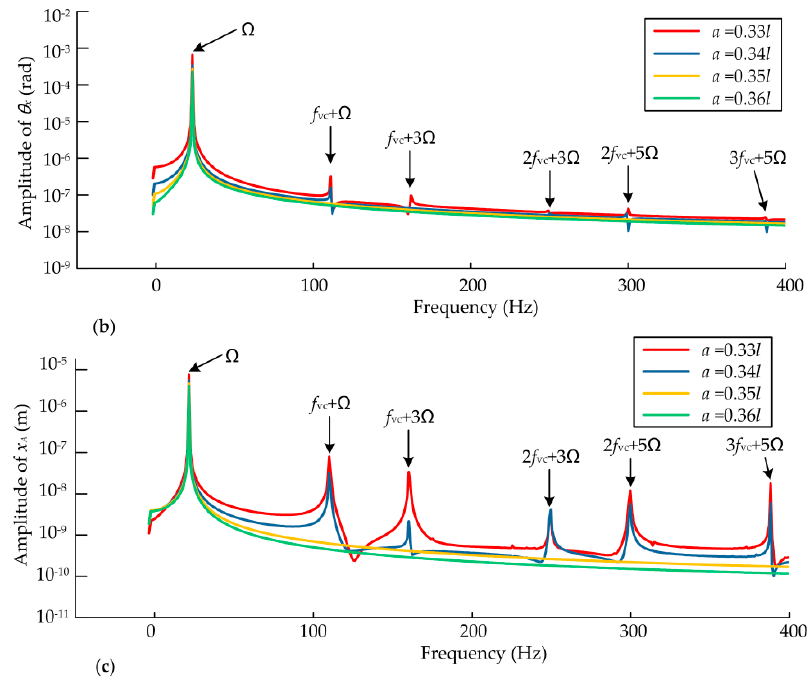
Figure 11. The spectra of dynamic responses for different rotor offsets. ( a ) The spectra of x ; ( b ) The spectra of θ x ; ( c ) The spectra of x A .